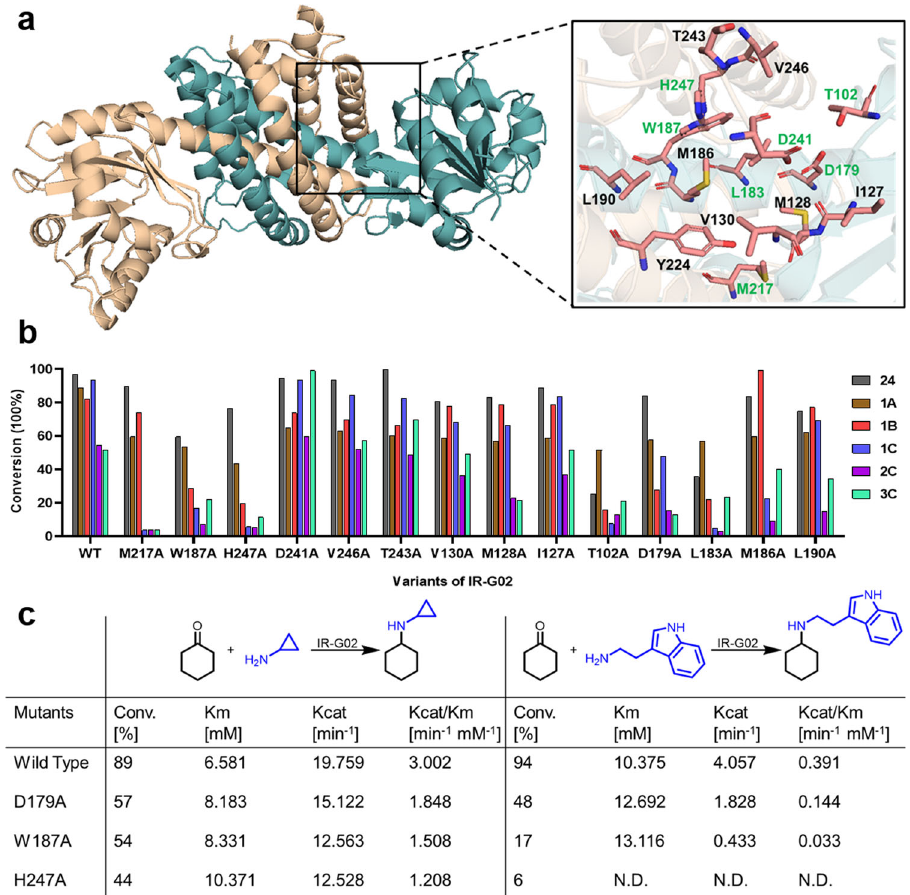
Fig. 4 Structural and mutagenesis data of IR-G02. a Apo - structure of IR-G02 (PDB: 7XE8, Supplementary Data 1) and the residues inside the active pocket at the interface. b Analysis of the conversions of the imine reductions and reductive aminations with wild-type and mutants of IR-G02. c Kinetic data of IR-G02 wild-type and mutants W187A, H247A, and M217A for ketone 1 . N.D. was not determined because of the low activity.